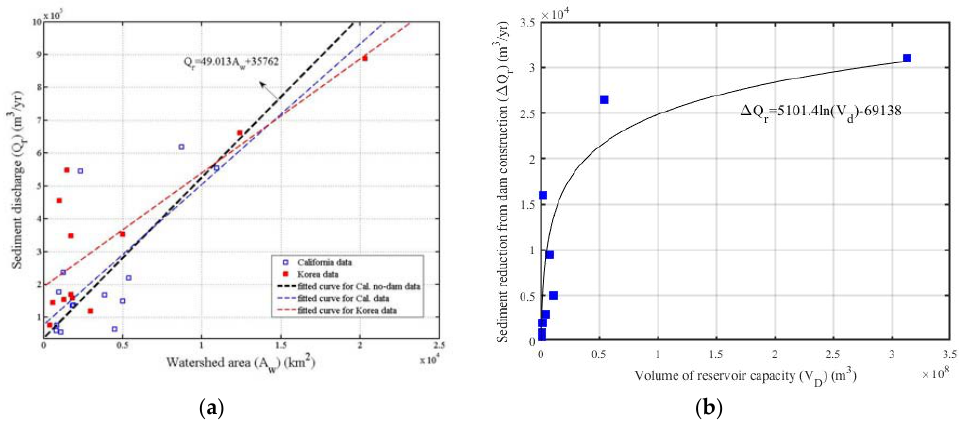
Figure 9. Comparison of ( a ) annual mean sediment discharge and ( b ) reduction in sediment volume by dam construction.